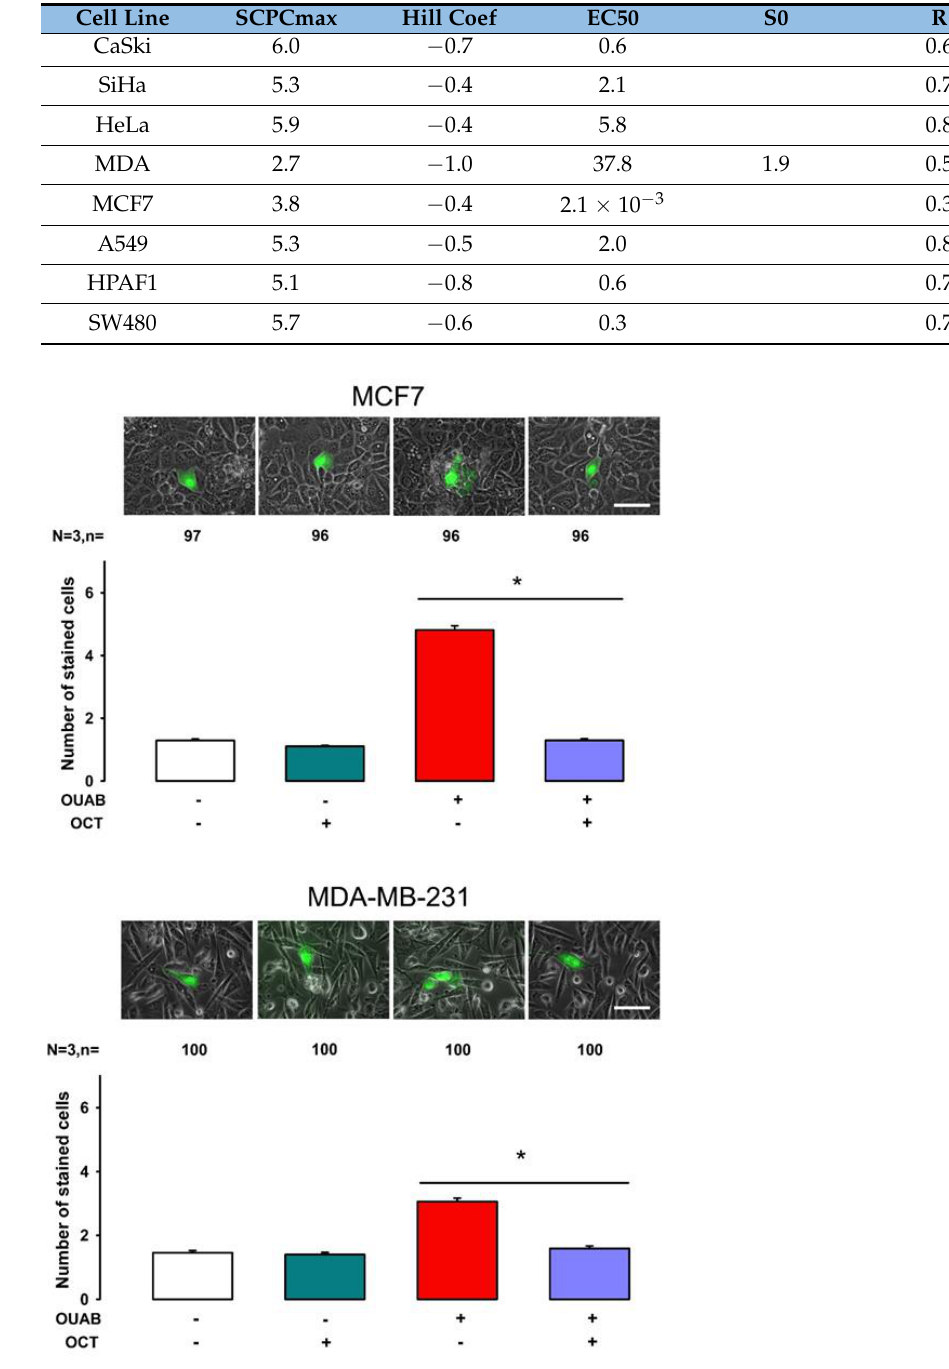
Table 2. Parametric values resulting after adjusting the experimental data, by regression, to the dose–response curve, logistics of three or four parameters, the last column shows the value of the correlation coefficient.